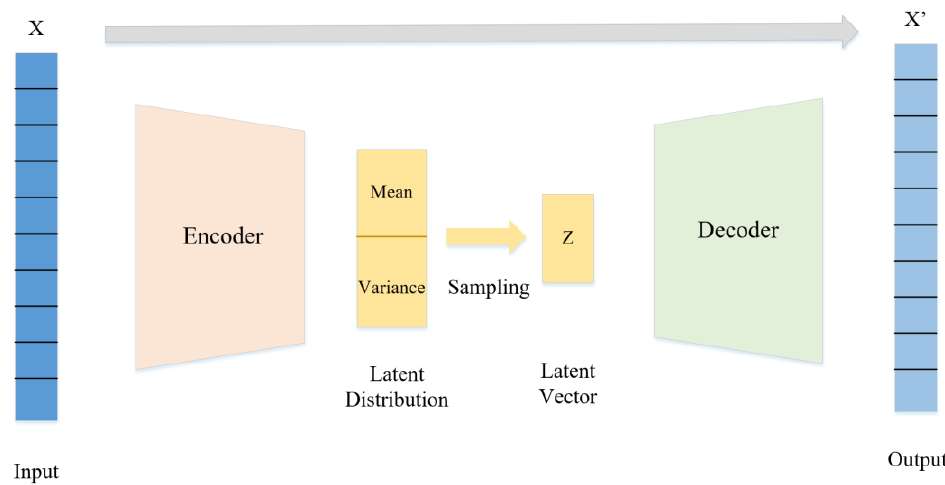
Figure 1. Architecture of the Variational Autoencoder (VAE).